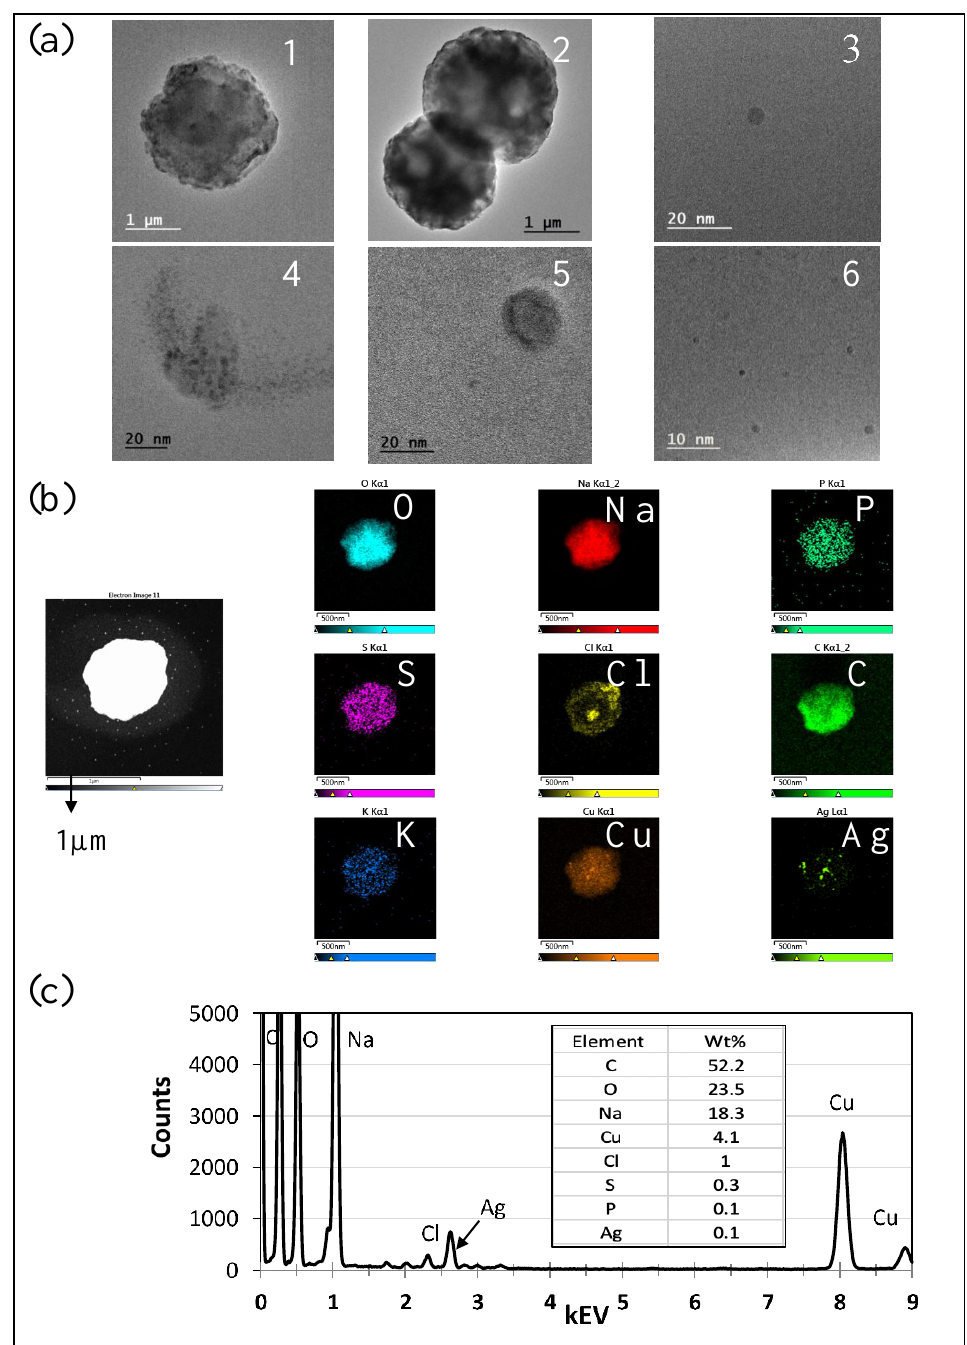
Figure 7. Microscopy analysis of particles collected from SSS aerosolization using TEM and EDS. ( a ) TEM images of particles collected on a TDS copper grid from aerosolized SSS, organized from low to high magnification and ranging in size from less than 20 nm to greater than 1 µ m. ( b ) Elemental maps of the particle used for analysis. The scale bar of the image is 1 µ m. The particle was found to contain the elements carbon (C), oxygen (O), sodium (Na), phosphorus (P), sulfur (S), chlorine (Cl), potassium (K), copper (Cu), and silver (Ag), from left to right, with scale bars of 500 nm. ( c ) EDS analysis of particle in image ( b ).